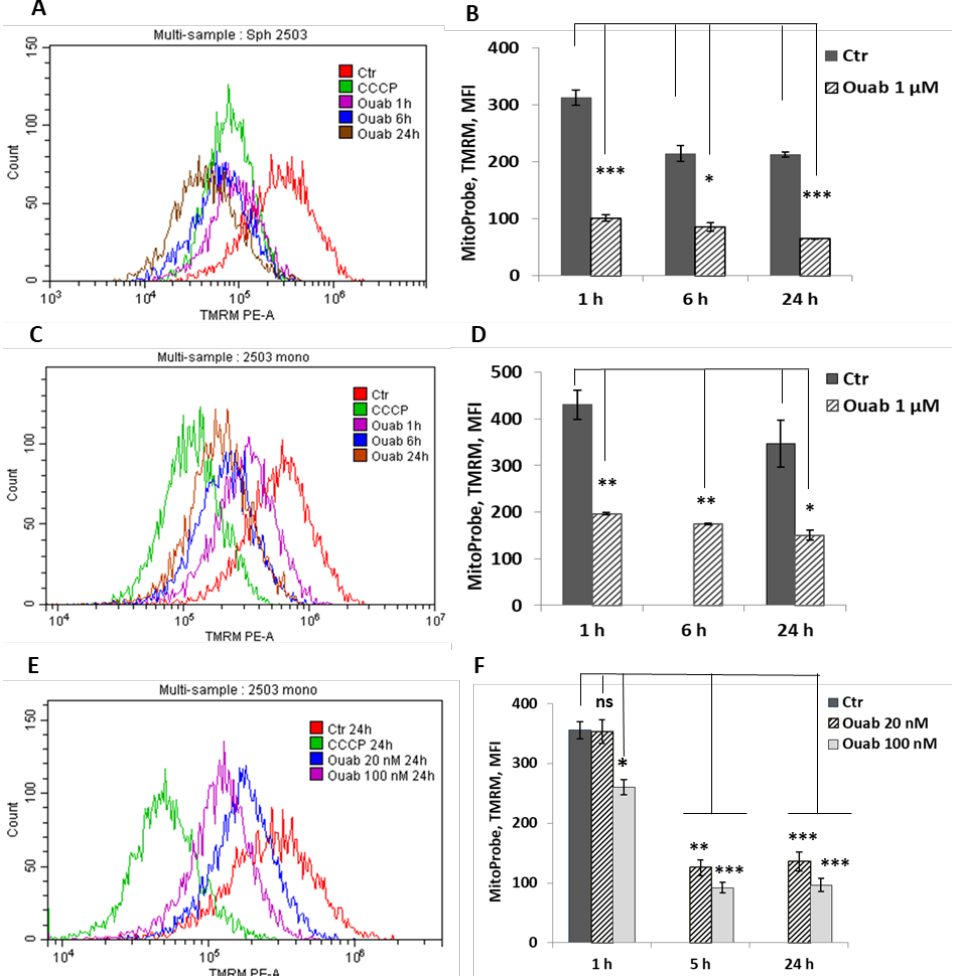
Figure 6. Ouabain-induced changes in the membrane potential of mitochondria in eMSCs growing in spheroids and in a monolayer. Cells in spheroids ( A , B ) and monolayer were treated with 1 μM ouabain ( C , D ) or 20 nM and 100 nM ouabain ( E , F ) and analyzed at the indicated time points using FACS. Changes in mitochondrial membrane potential (MMP) were assessed by TMRM (tetramethyl- rhodamine, methyl ester) fluorescence. The protonophore CCCP (carbonyl cyanide m-chlorophenyl hydrazone), an inhibitor of mitochondrial oxidative phosphorylation, was used to define the baseline for the analysis of MMP; 50 mM CCCP was added to probes with cells before FACS analysis. Data are shown as mean + SD (n = 3) from one experiment from two performed on the same scheme. * p < 0.5, ** p < 0.05, *** p < 0.005 vs. the control cells. Ctr—control cells.